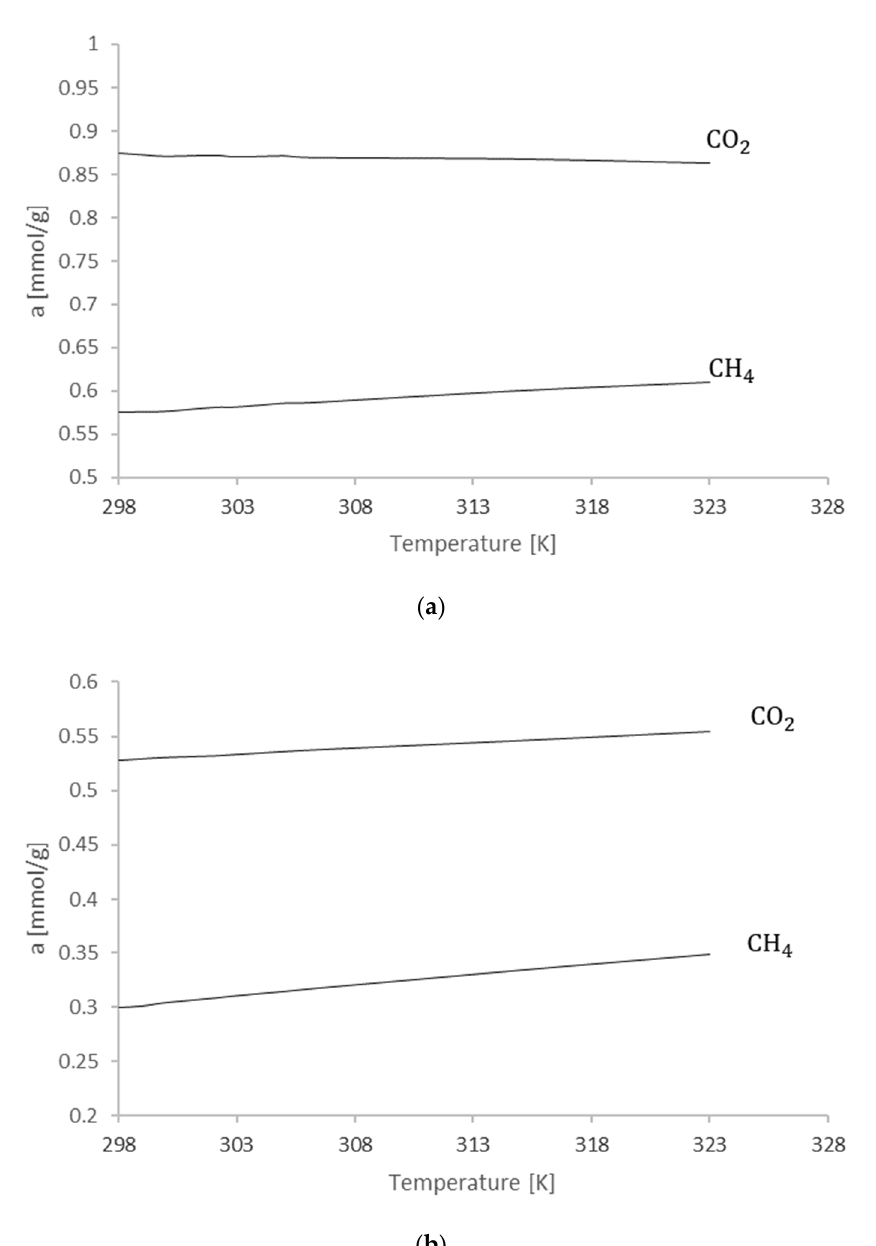
Figure 6. ( a ) Change in sorption capacity for CO 2 and CH 4 depending on the temperature for P1. ( b ) Change in sorption capacity for CO 2 and CH 4 depending on the temperature for P2.